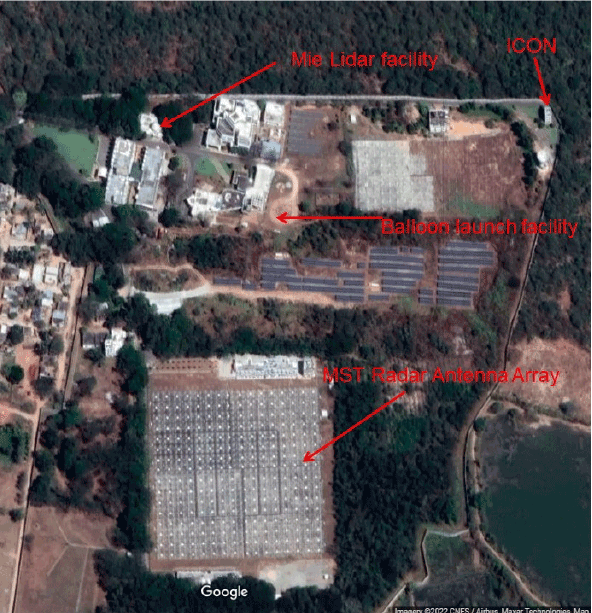
Figure 8. Map of the balloon launch facility and remote sensing ap- paratus at NARL (from Google Maps). Imagery © 2022 CNES/Air- bus, Maxar Technologies, Map data ©